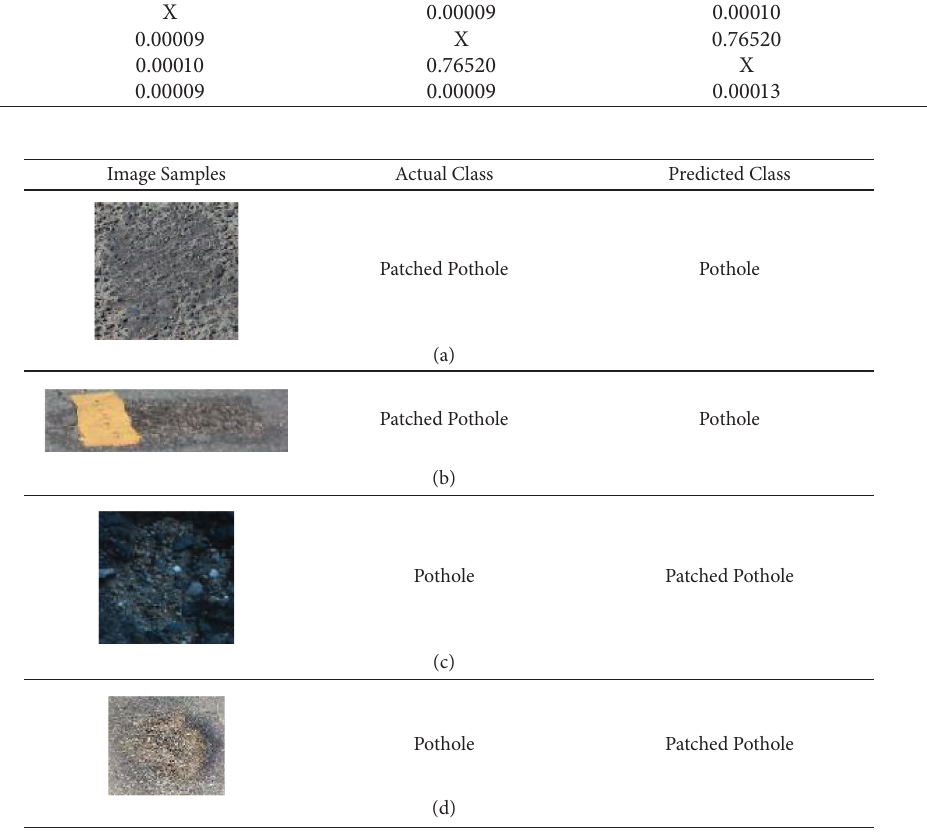
Figure 16: Illustrations of misclassified